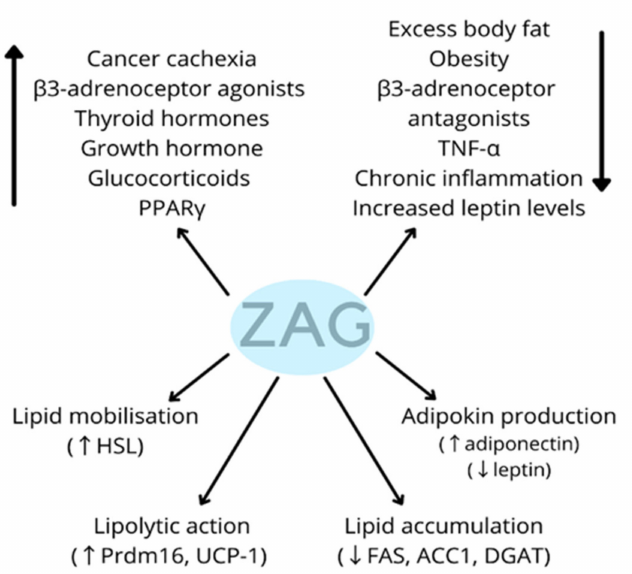
Figure 1. Regulation and role of ZAG. ZAG—zinc-a2-glycoprotein, PPAR γ —peroxisome proliferator- activated receptors γ , TNF- α —tumour necrosis factor- α , HSL—hormone-sensitive lipase, Prdm16— PR domain containing 16, UCP-1—uncoupling protein 1, FAS—fatty acid synthase, ACC1—acetyl- CoA carboxylase, DGAT—diglyceride